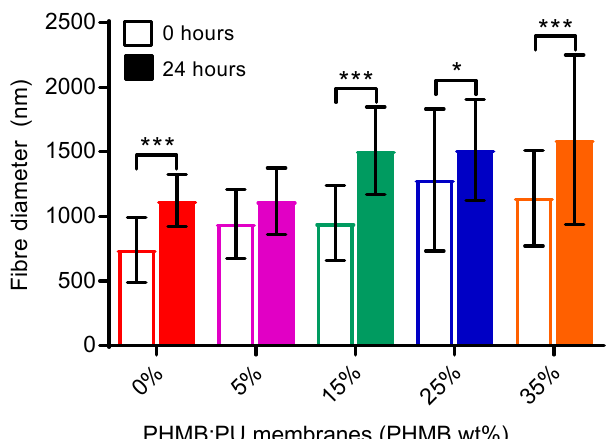
Figure 2. Fibre diameters (nm) of electrospun PHMB:PU membranes. Samples included untreated membranes (0 hours) and membranes after immersion in PBS for 24 hours. N = 20–50, taken from three different areas of material imaged with SEM. Error bars describe the standard deviation from the mean. * signifies a significant percentage change after immersing samples in PBS (* for p < 0.05; *** for p < 0.0001).